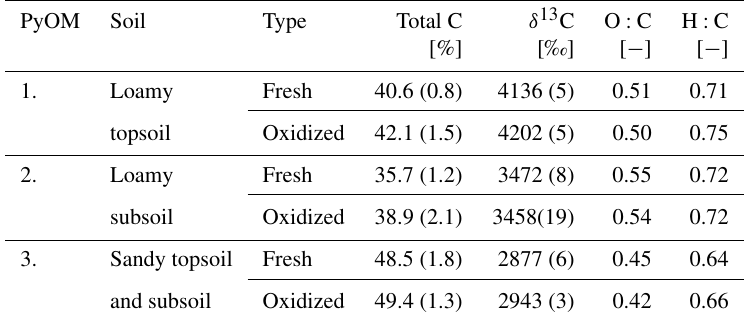
Table 2. Total C, δ 13 C, O : C and H : C ratios of PyOM used for the corresponding soil column experiment ( ± 1SE). See Sect. 2.4 for